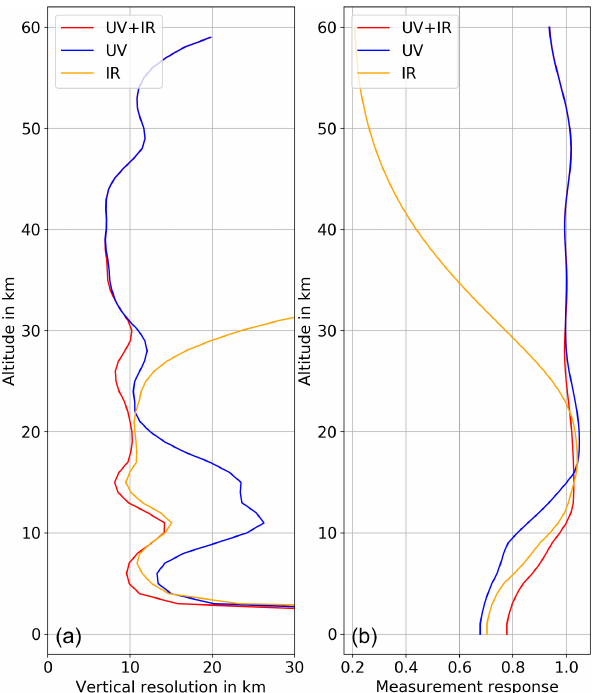
Figure 4. (a) Vertical resolution of the ozone profiles shown in Fig. 2 given by the inverse main diagonal elements of the AK ma- trix. (b) Altitude-dependent measurement response functions de- rived as the sum of the rows of the AK